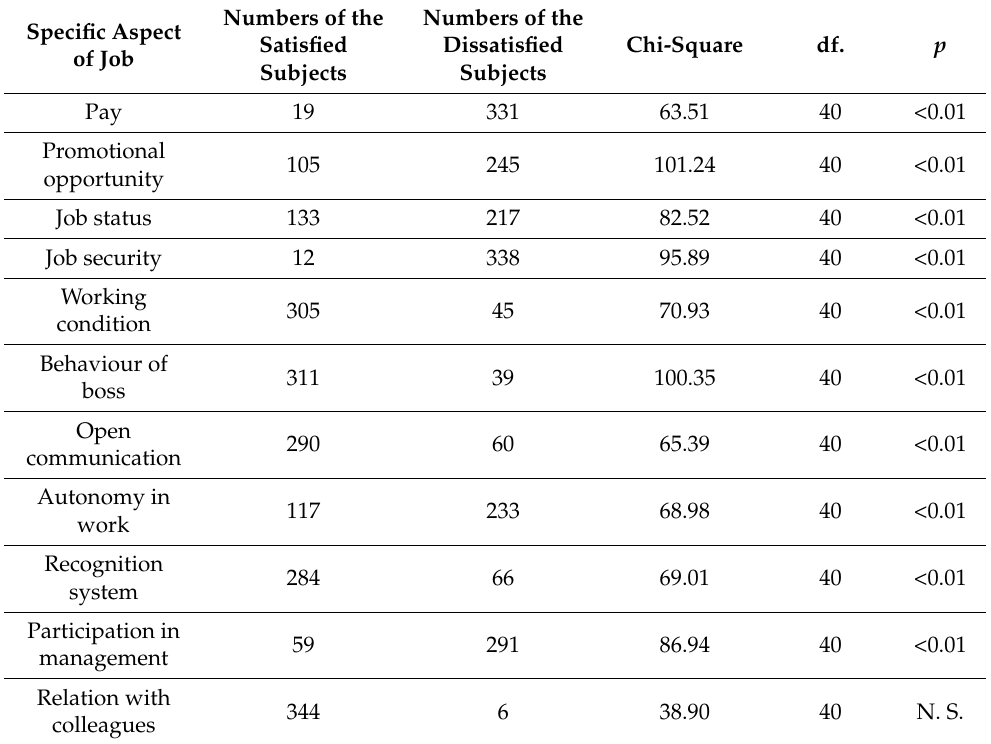
Table 5. Composite chi-square regarding the satisfaction and dissatisfaction of respondents with specific professional aspects (N = 350).